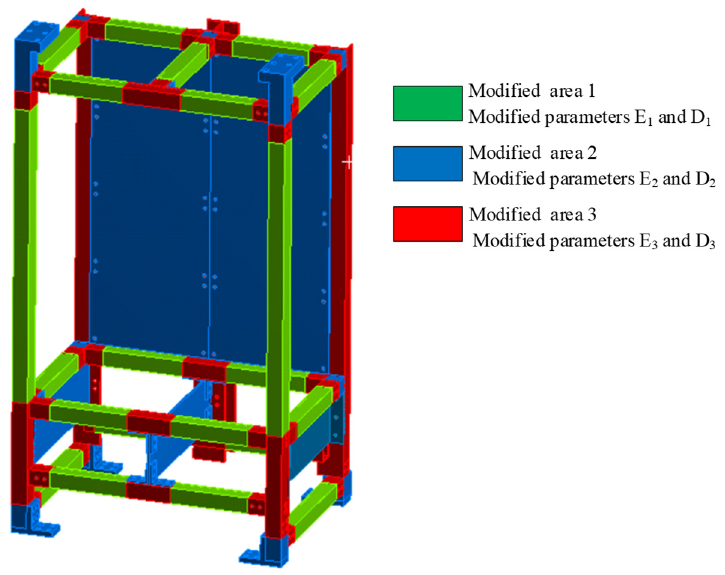
Figure 7. Modified area division and modified parameters of experiment rack simulator. Table 3. Values for each level of the parameters that needed to be corrected.